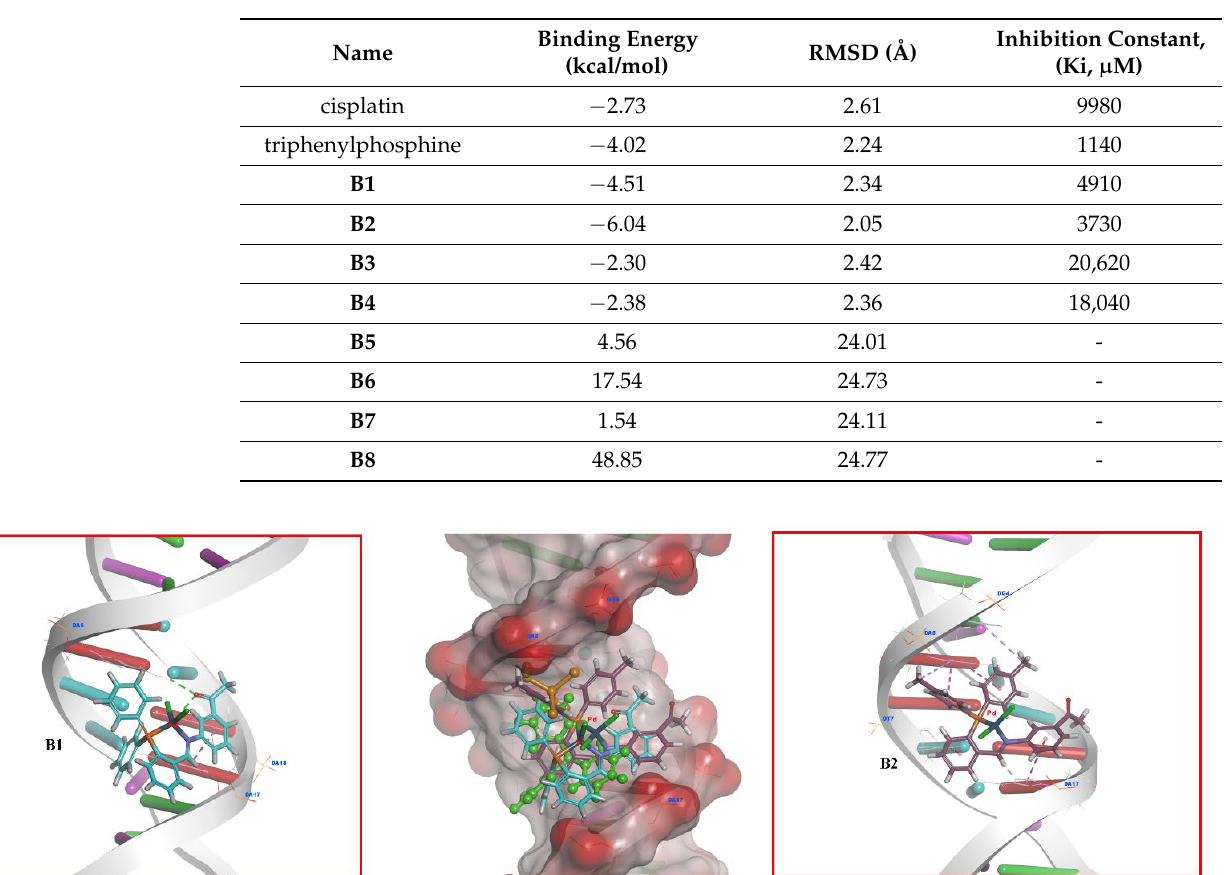
Table 1. Docking results of the Pd ( B1 , B2 , B5 , and B6 ) and Pt ( B3 , B4 , B7 , and B8 ) complexes and the control compounds (cisplatin and triphenylphosphine) with DNA.